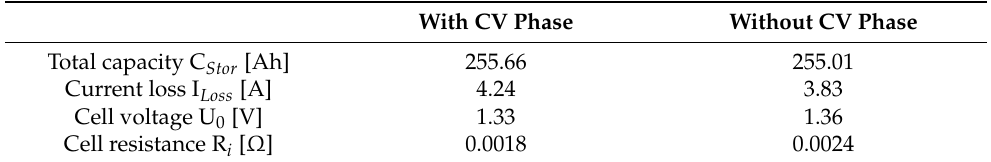
Table 5. Comparison of the optimization parameters with and without CV phase after